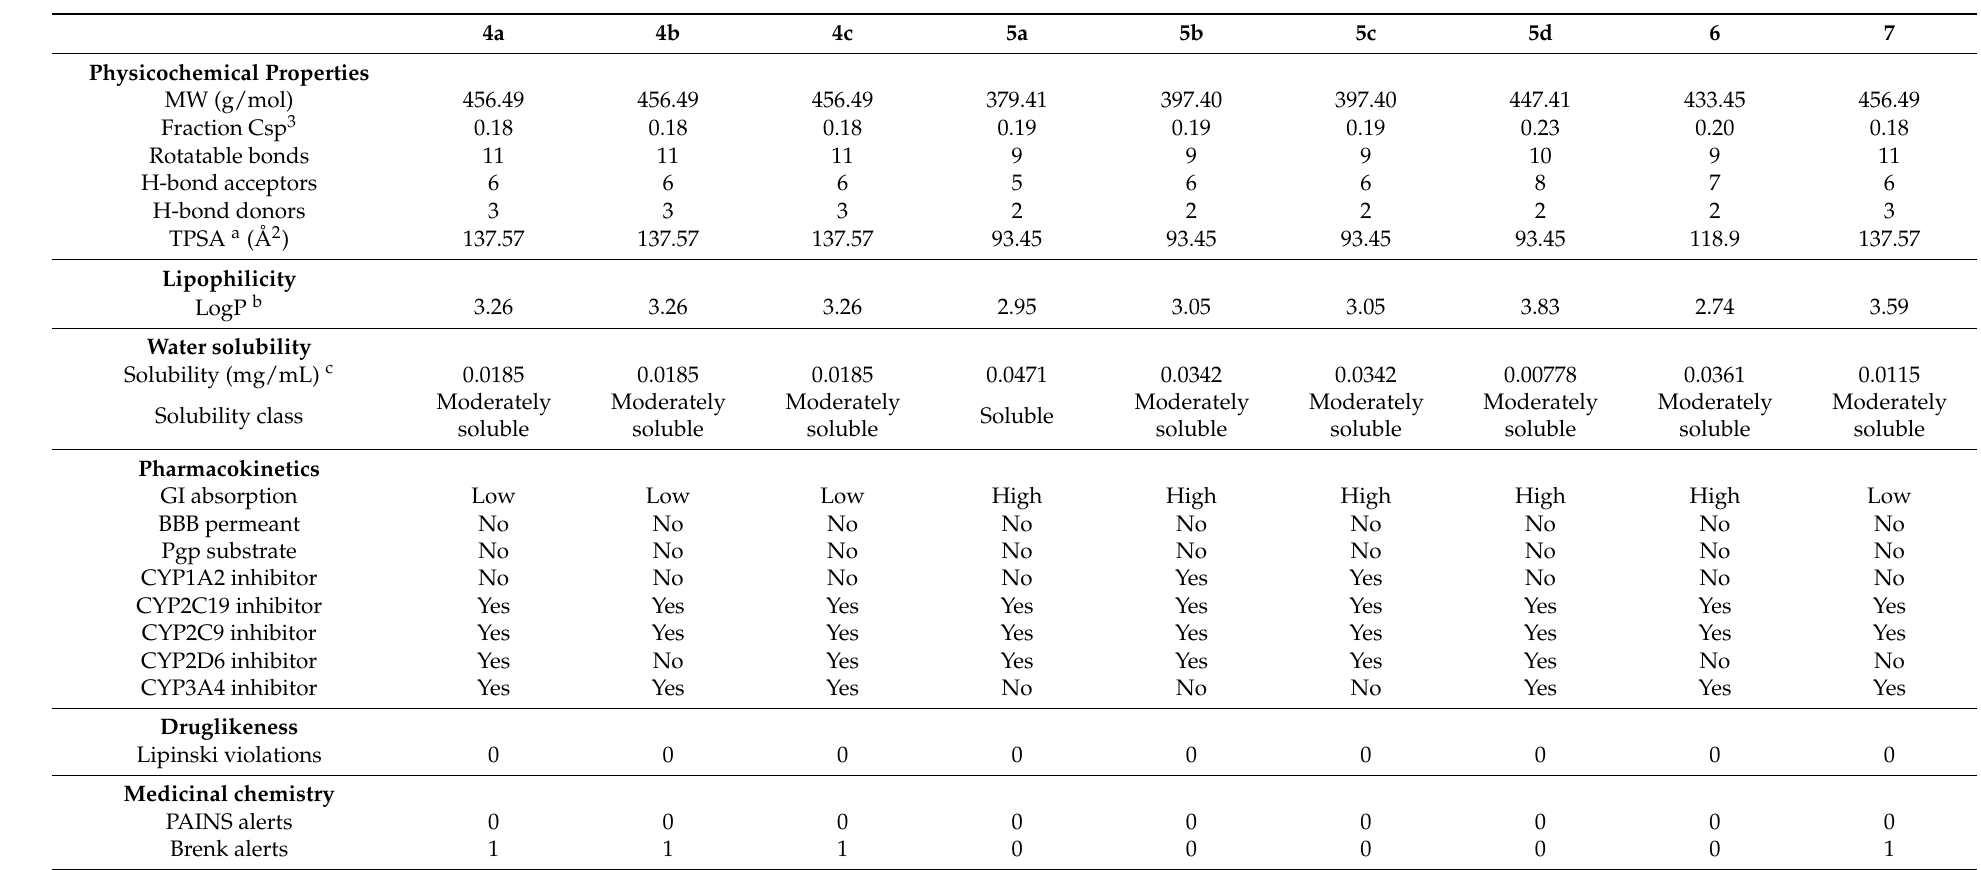
Table 3. Predicted pharmacokinetics and drug-like properties of compounds 4 – 7